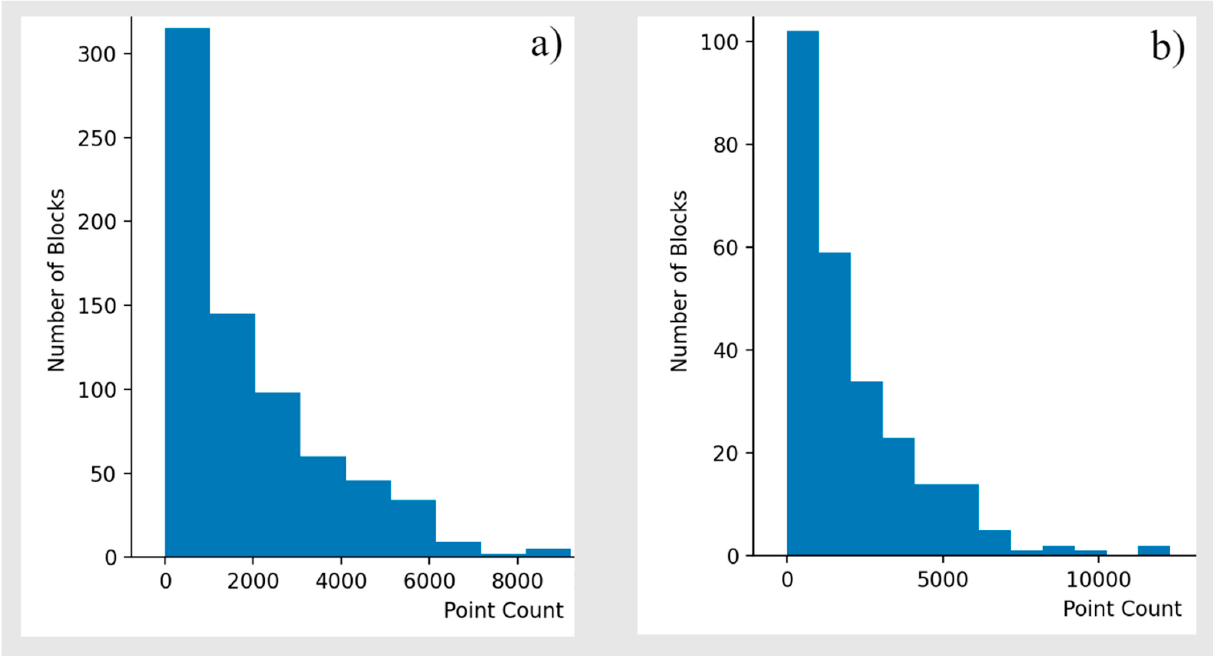
Figure 7. The distribution of HDF training and validation blocks of Site A: ( a ) Training data blocks. ( b ) Validation data blocks.